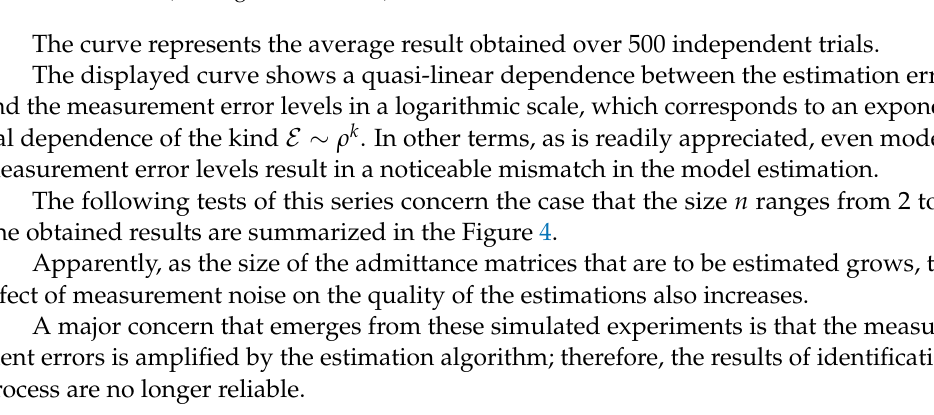
Figure 3. Mismatch in an estimated two-port model resulting from random errors in the data-pairs. The horizontal axis displays the standard deviation of the measurement errors (in logarithmic scale), while the vertical axis displays the Frobenius distance between the actual and estimated two-port admittance matrix (in a logarithmic